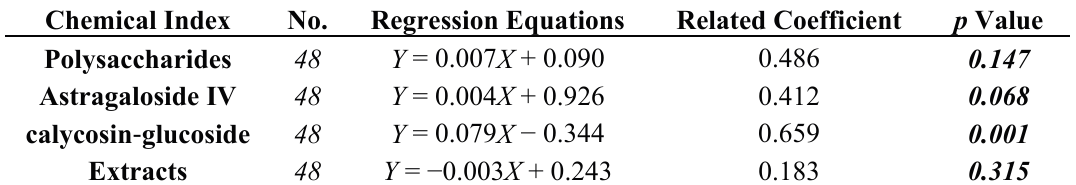
Figure 3. Correlation between sweetness and the contents of total polysaccharides, astragaloside IV, calycosin-glucoside, and extracts of RA. Plot showing the correlation between sweetness of RA and the contents of total polysaccharides, astragaloside IV, calycosin-glucoside, and extracts of RA; Results of correlation analysis between every pair of elements in RA are expressed in the form of bands with ranges between − 1 and +1; band colors from blue ( − 1) to reddish brown (+1) represent correlation ranging from negative to positive. Deeper color indicates stronger correlation. Table 2. Linear regression equations of sweetness ( X ) and the contents of polysaccharides, calycosin-glucoside, astragaloside IV, and extracts (Y) of